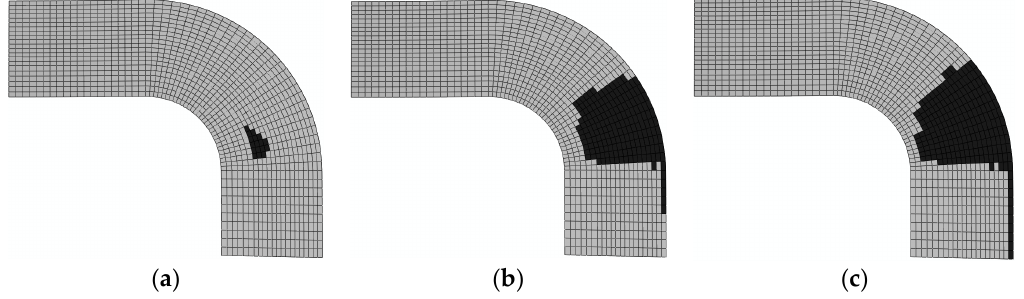
Figure 17. Layer damage obtained by the secondary nominal strain criterion: ( a ) 73.3 kN; ( b ) 178.2 kN; and ( c ) 213.1 kN.